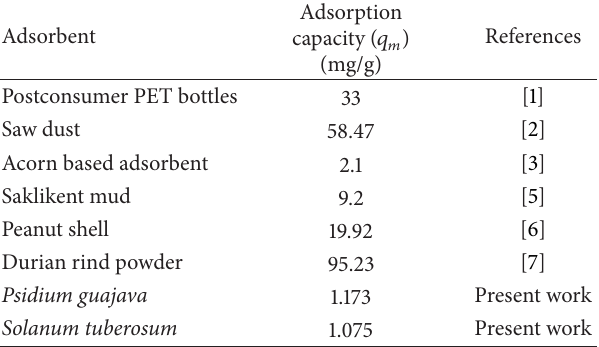
Table 9: Comparison of adsorption study with some adsorbents studied